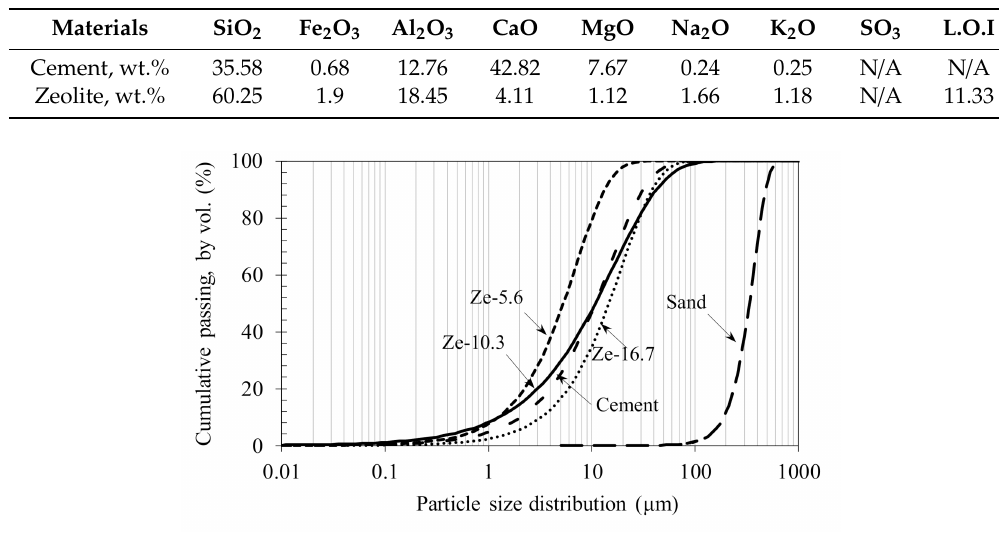
Table 2. Chemical compositions of cementitious materials.